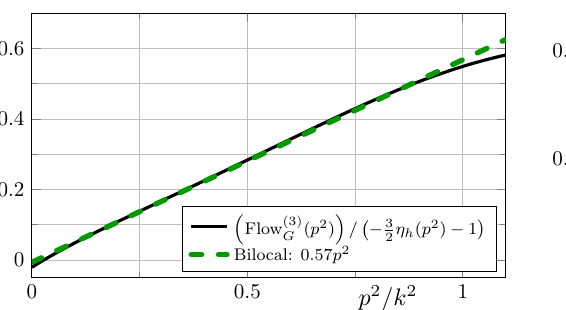
tantly, the inclusion of a p 4 term in the left panel offers no significant improvement. Note that the constant parts of the functions are irrelevant for the beta functions since they are extracted from a different tensor = λ = λ projection. For p 2 > k 2 the momentum dependence of the flows is not 6 3 5 polynomial